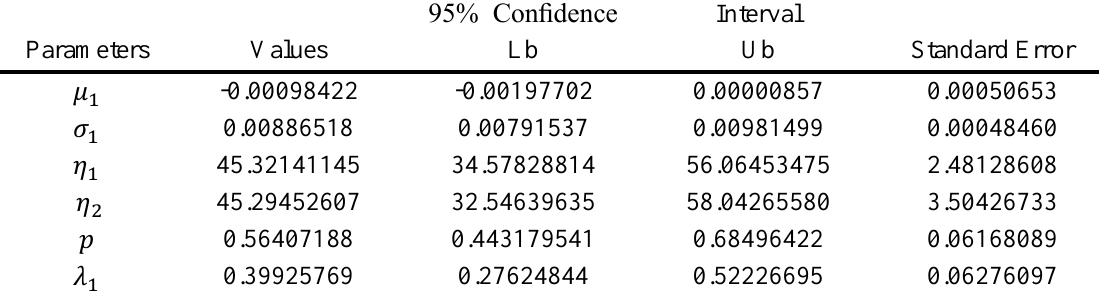
Table 3. Estimated parameters associated with WHGS3 sesame price under DEJD